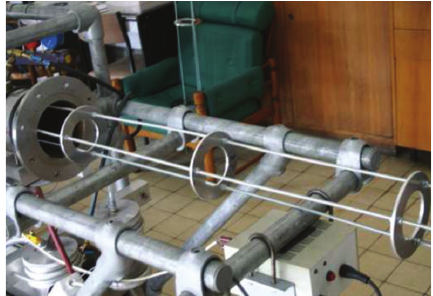
Figure 6: Experimental setup of obstacles location along the detonation tube [33].